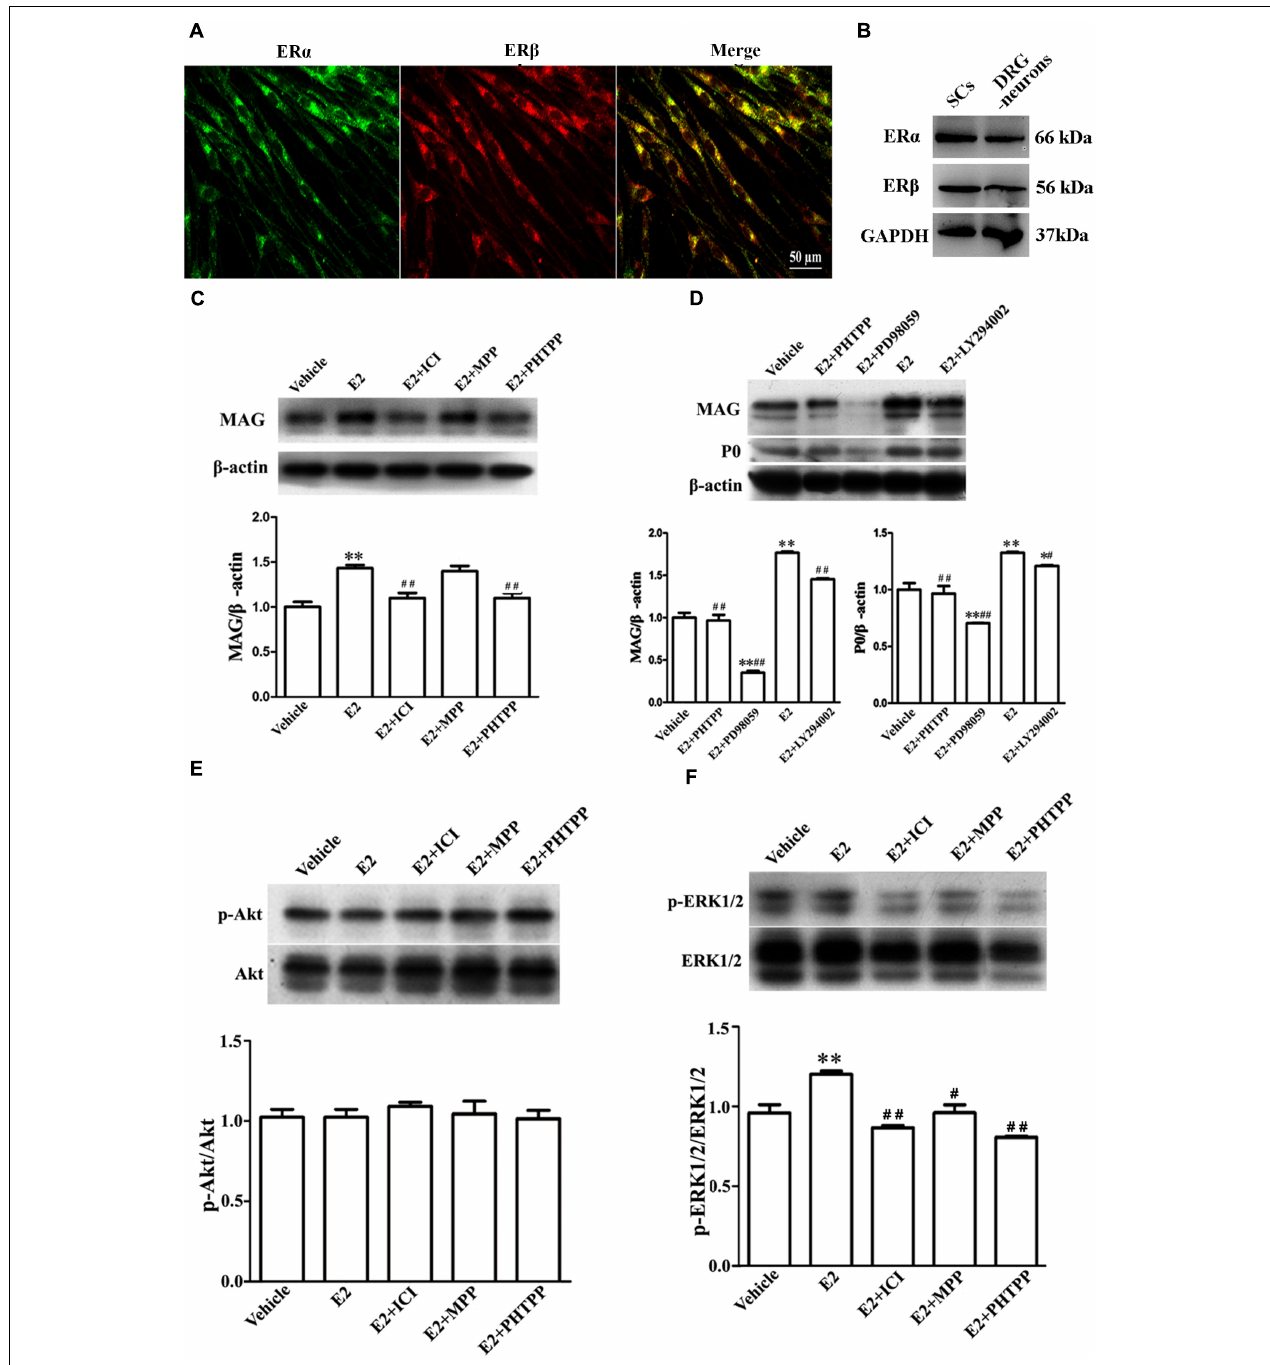
FIGURE 5 | E2 enhances Schwann cell differentiation via ER β -ERK1/2 signaling. (A) Immunohistochemistry with anti-ER α (green) and anti-ER β (red) of Schwann cells. Scale bar, 50 µ m. (B) ER α and ER β expression in the cultured pure Schwann cells and DRG neurons s, as shown by western blotting. (C) Western blotting compared the MAG expression in differentiated SCs treated with E2 alone or with E2 plus ICI182780 or MPP (antagonist of ER α ) or PHTPP (antagonist of ER β ) for 3 days. (D) Western blotting compared the MAG and P0 expression in differentiated SCs treated with E2 alone or with E2 plus PHTPP or PD98059 (antagonist of MEK1/2) or LY294002 (antagonist of PI3K) for 3 days, and vehicle as control, β -actin served as an internal standard. (E,F) Showed the phosphorylation of AKT (E) and ERK 1/2 (F) in differentiated SCs after treatments with E2 alone or with E2 plus ICI182780 or MPP or PHTPP for 3 days. ∗∗ p < 0.01 versus vehicle, and # p < 0.05, ## p < 0.01 versus E2. One-way ANOVA, n = 3 cultures per group. All the data are mean ± SEM.